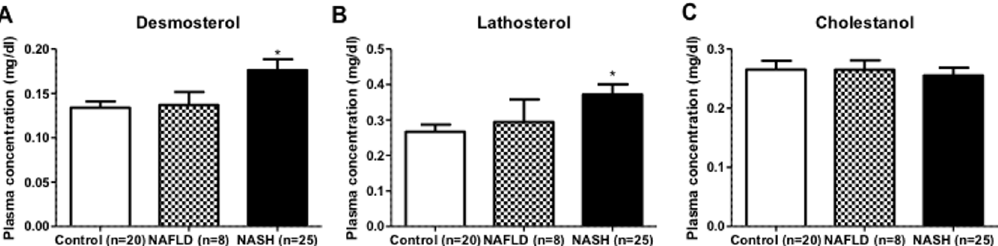
Figure 8. Plasma cholesterol precursor levels in severely obese patients. Serum levels of (A) desmosterol, (B) lathosterol and (C) cholestanol were measured in control (n=20), NAFLD (n=8) and NASH (n=25) patients. All values are shown as absolute levels (mg/dl serum). *P ,